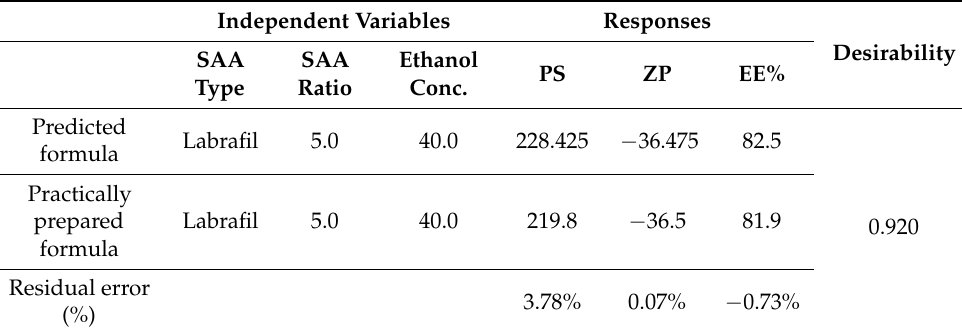
Table 4. Validation of the optimization model using the desirability function.